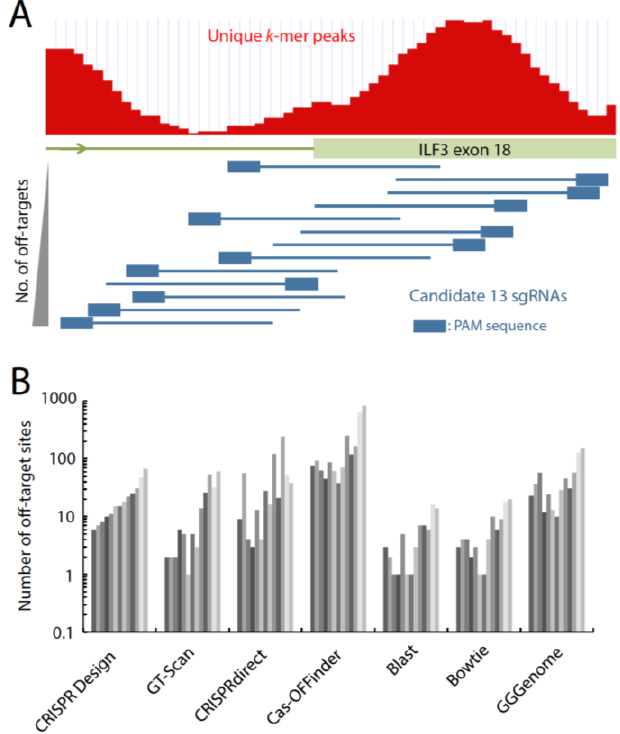
Figure 2. Tendency of identified off-target sites by sgRNA design and sequence search